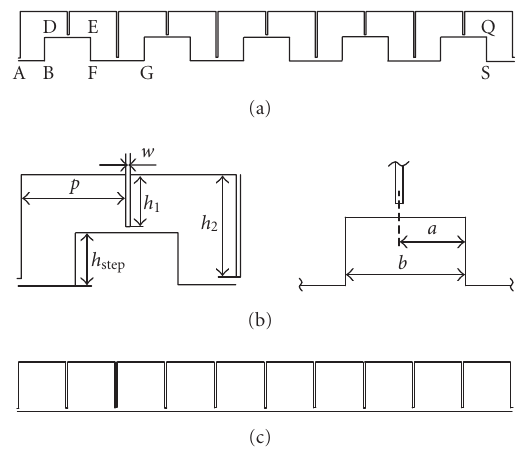
Figure 3: Schematic of labyrinth seals: (a) typical high-low labyrinth seal configuration; (b) seal dimensions and relative tooth axial position (0 . 0 ≤ a/b ≤ 1 . 0); (c) straight-through labyrinth seal